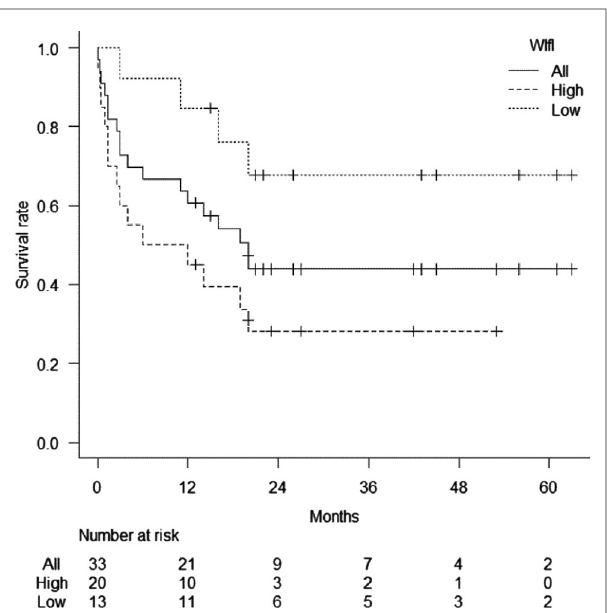
FIGURE 1 | Survival rates of all patients with chronic limb-threatening ischemia after cardiac surgery. Patients were divided into two groups, high- and low-wound, ischemia, and foot infection (WIfI) clinical stage. The 3-, 6-, 12-, and 24-month survival rates were 72.7%, 66.7%, 60.6%, and 43.9%, respectively. The survival rates were signi fi cantly worse in the high-WIfI group than in the low-WIfI